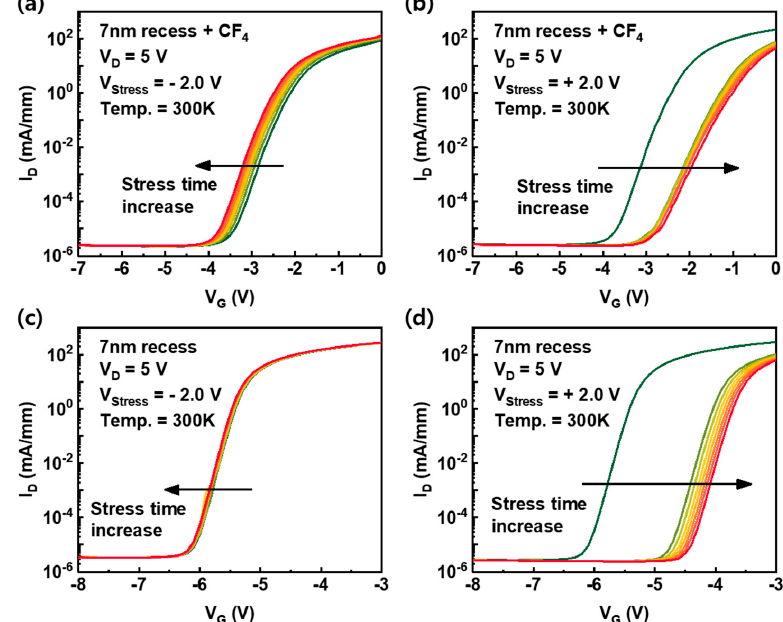
Figure 6. ( a , b ) The change in I-V transfer curves of the 7-nm recess + CF 4 device under negative and positive gate bias stress conditions according to stress time, respectively. ( c , d ) The change in I-V transfer curves of the 7-nm recess device under negative and positive gate bias stress conditions, respectively.